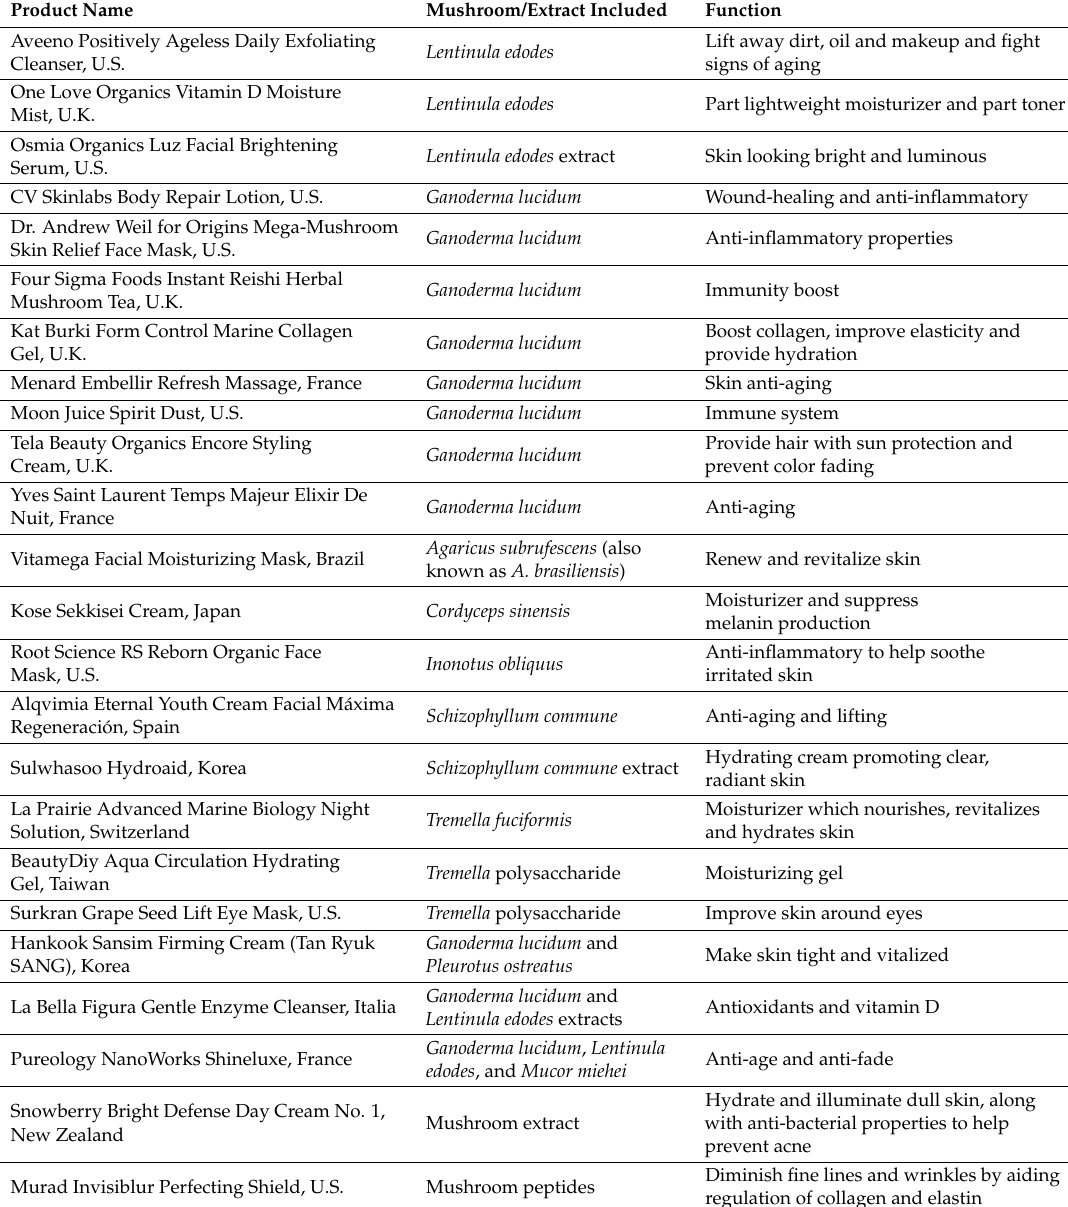
Table 2. Cosmetic products containing mushrooms and their